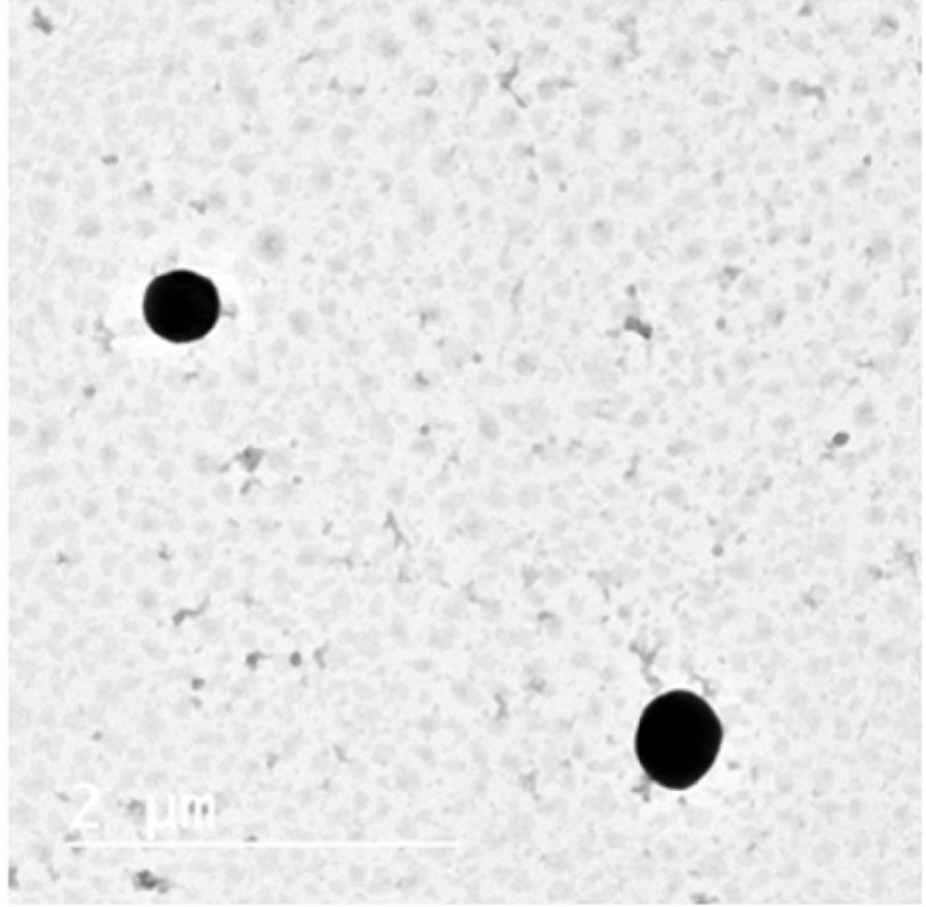
Figure 2. TEM micrograph of the optimized DRN loaded niosomes dispersion (N7).